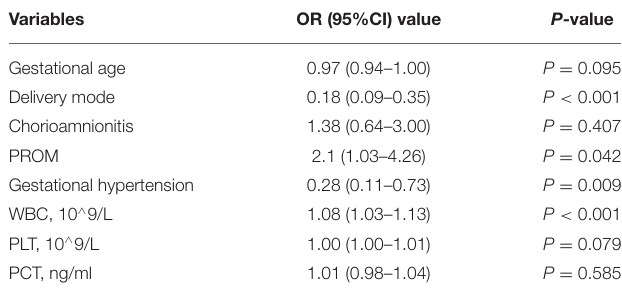
TABLE 2 | Outcome of UU infection and non-infection preterm infants. Outcome